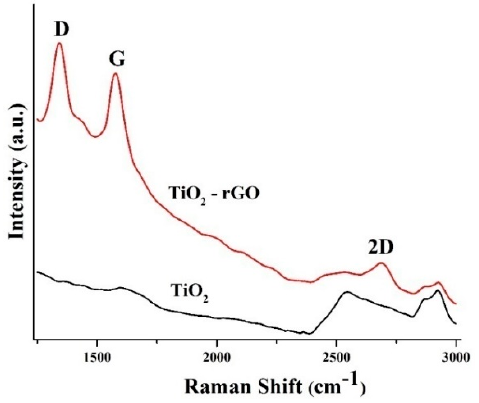
Figure 5. Raman spectra of TiO 2 and TiO 2 –rGO films.